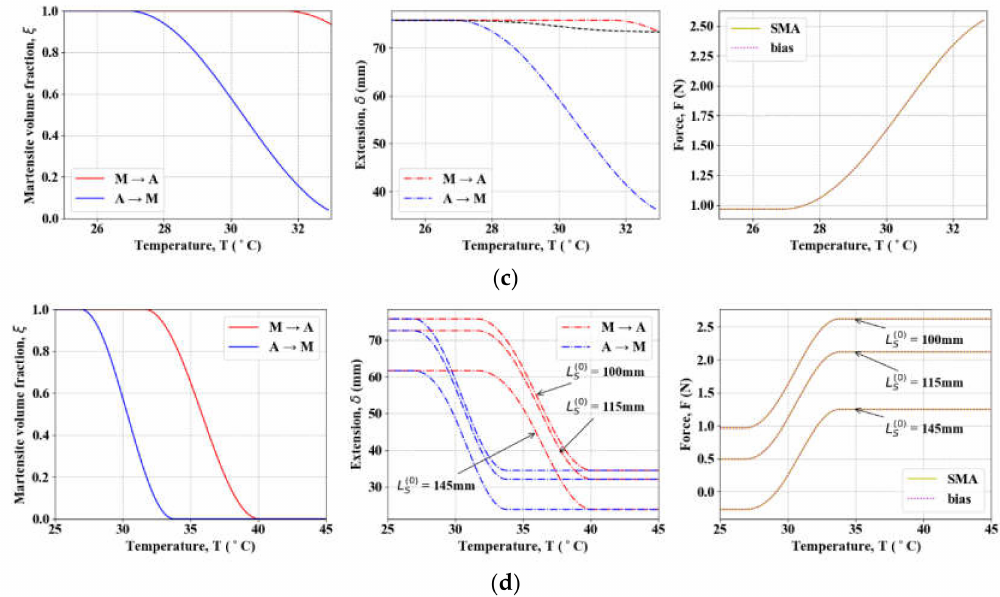
( 0 ) ( 0 ) ( 0 ) ( 0 ) = 100, L = 100): ( a ) full = 100, L = 100): ( a ) full S b S b A . A . → →